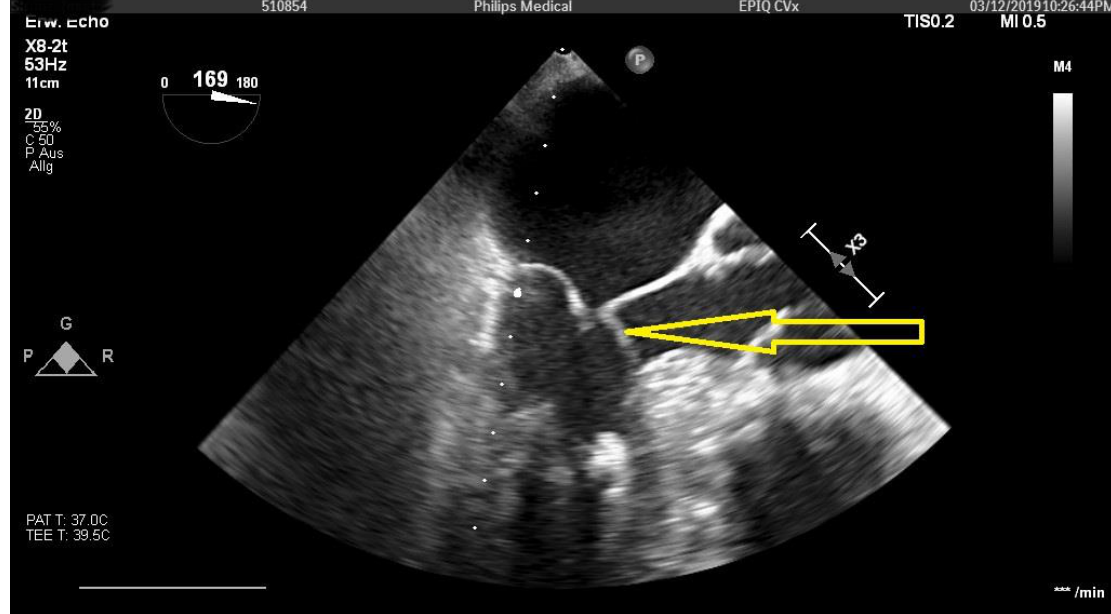
Figure 2. Systolic anterior movement of the anterior mitral leaflet (indicated by yellow arrow).